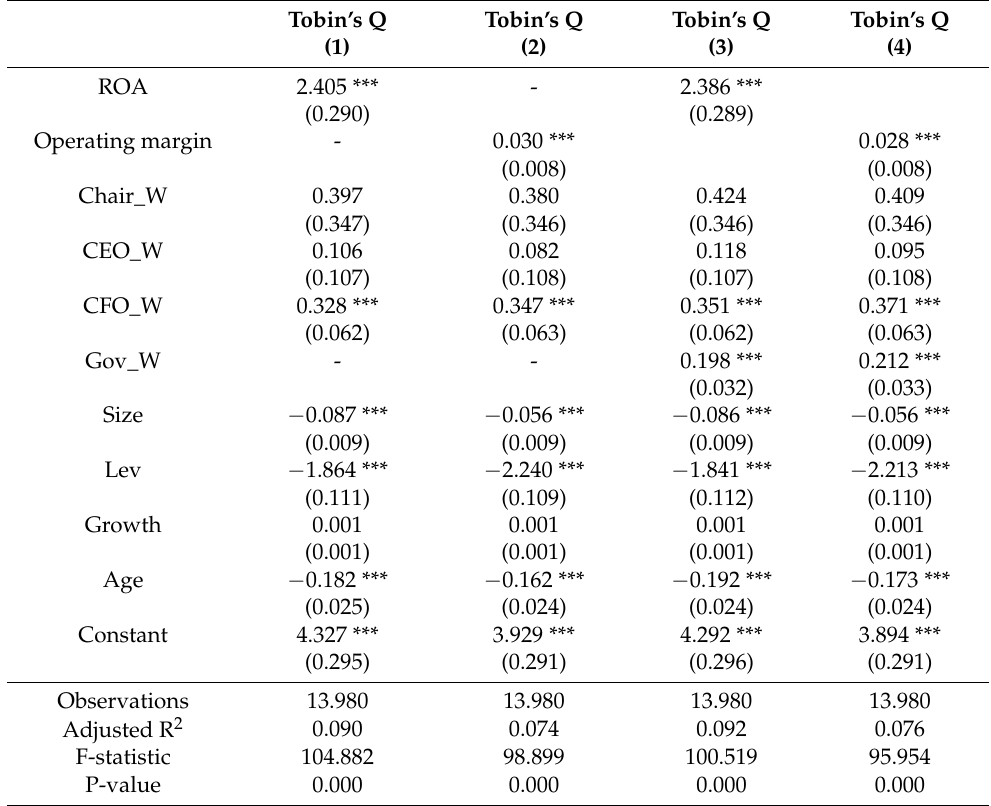
Table 5. Women on boards and firm